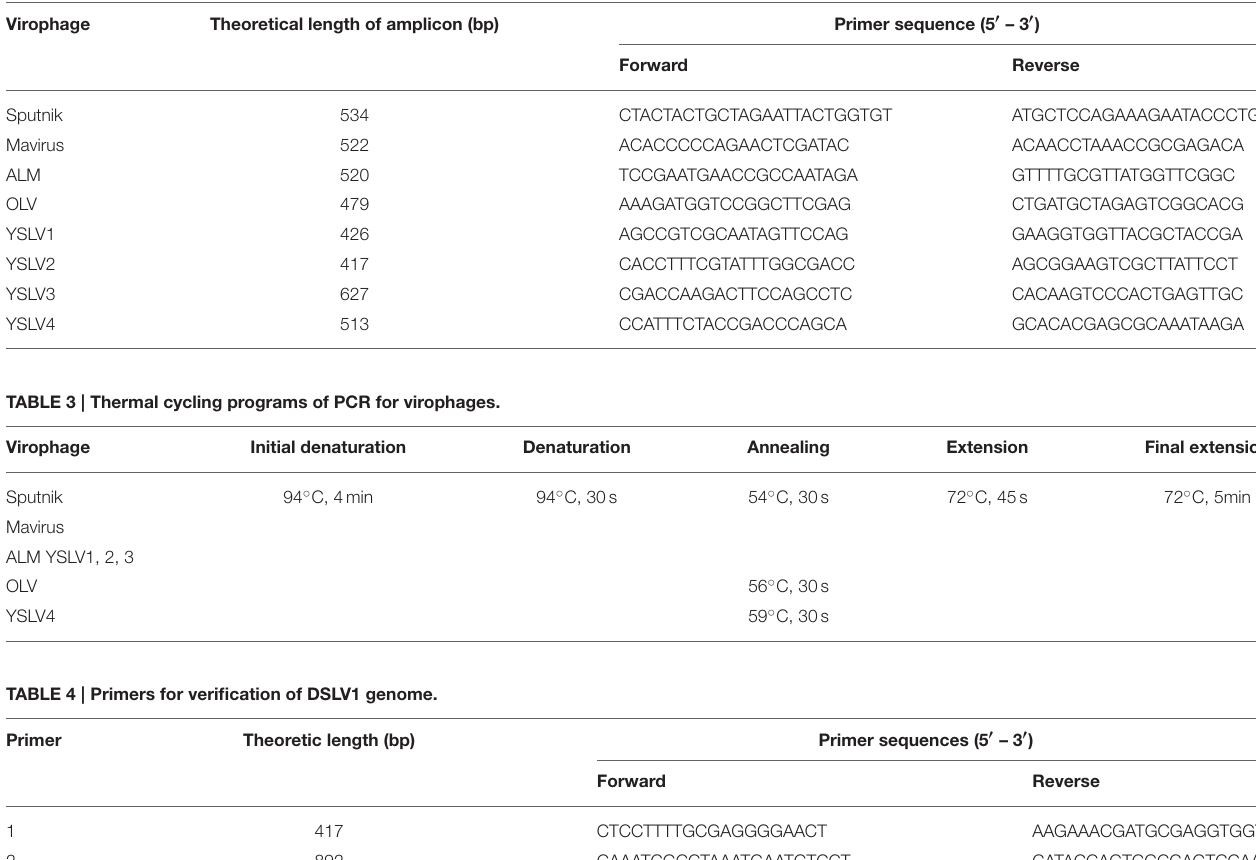
TABLE 2 | Eight pairs of virophage MCP genes specific primers designed in this study.